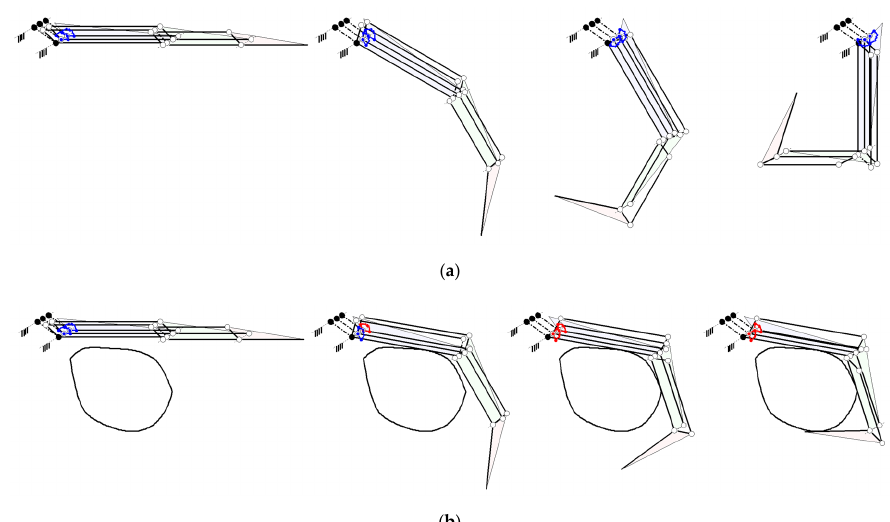
Figure 4. ( a ) Natural motion and ( b ) self-adaptive grasping motion of the proposed finger: blue and red color springs represent springs uncompressed and compressed by external forces, respectively.